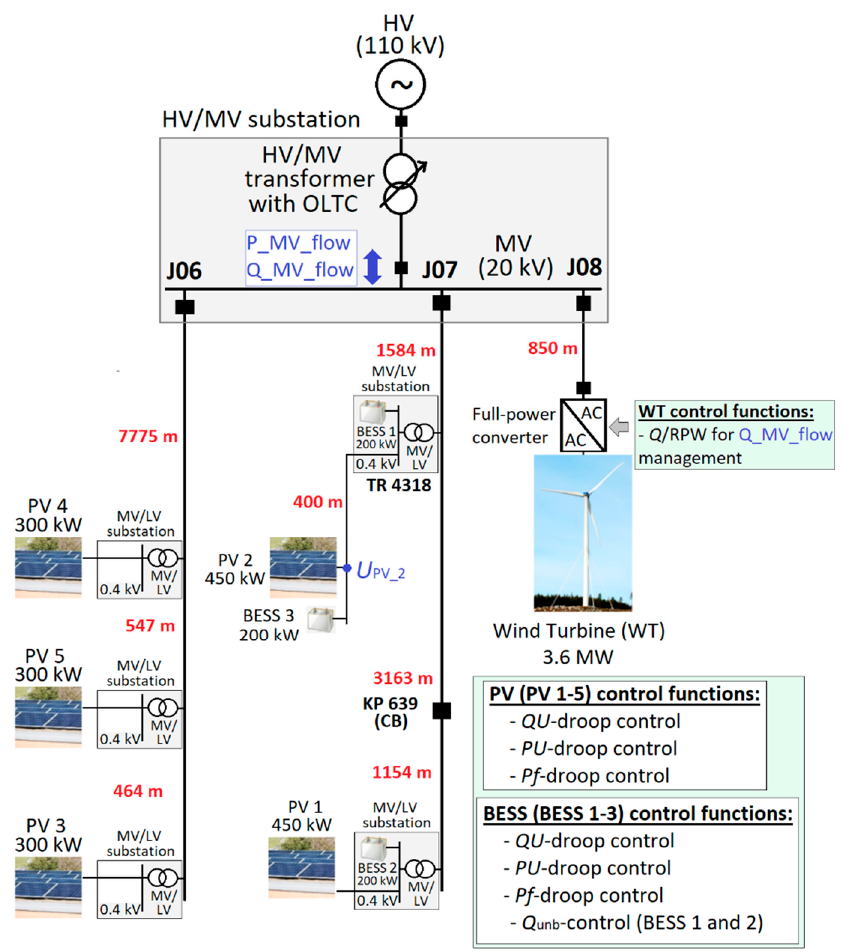
Figure 1. One-line diagram of the studied SSG in future scenario with more PV and BESS units in LV network, as well as with control functions applied in WT, PVs, and BESSs.